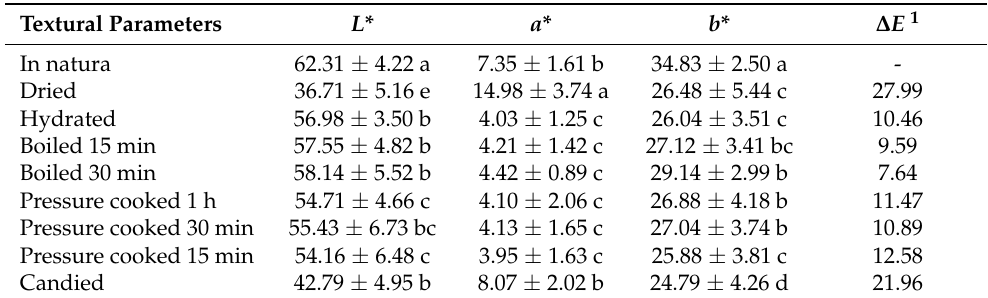
Table 3. Colour coordinates along the process and for different cooking options for cultivar Martainha. Textural Parameters L * a